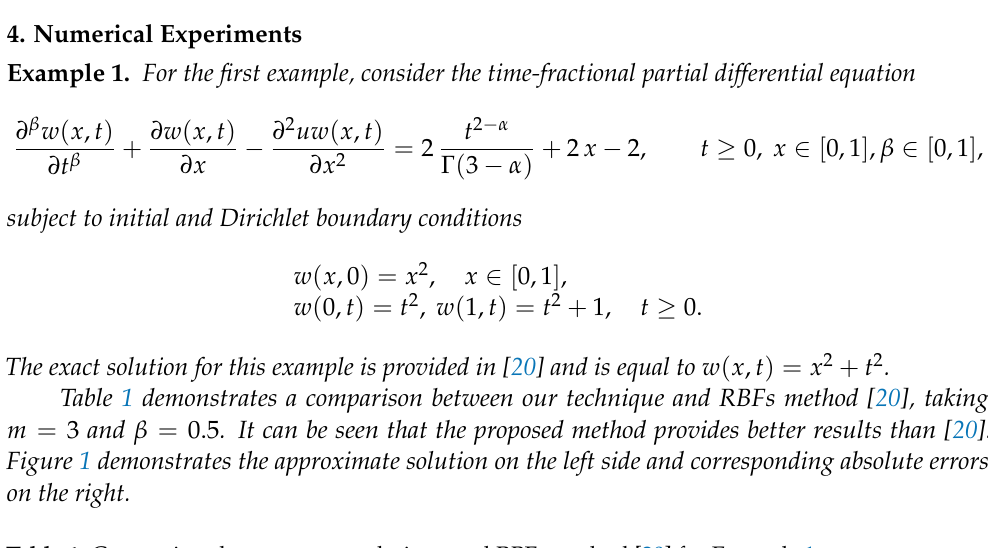
Table 1. Comparison between our technique and RBFs method [20] for Example